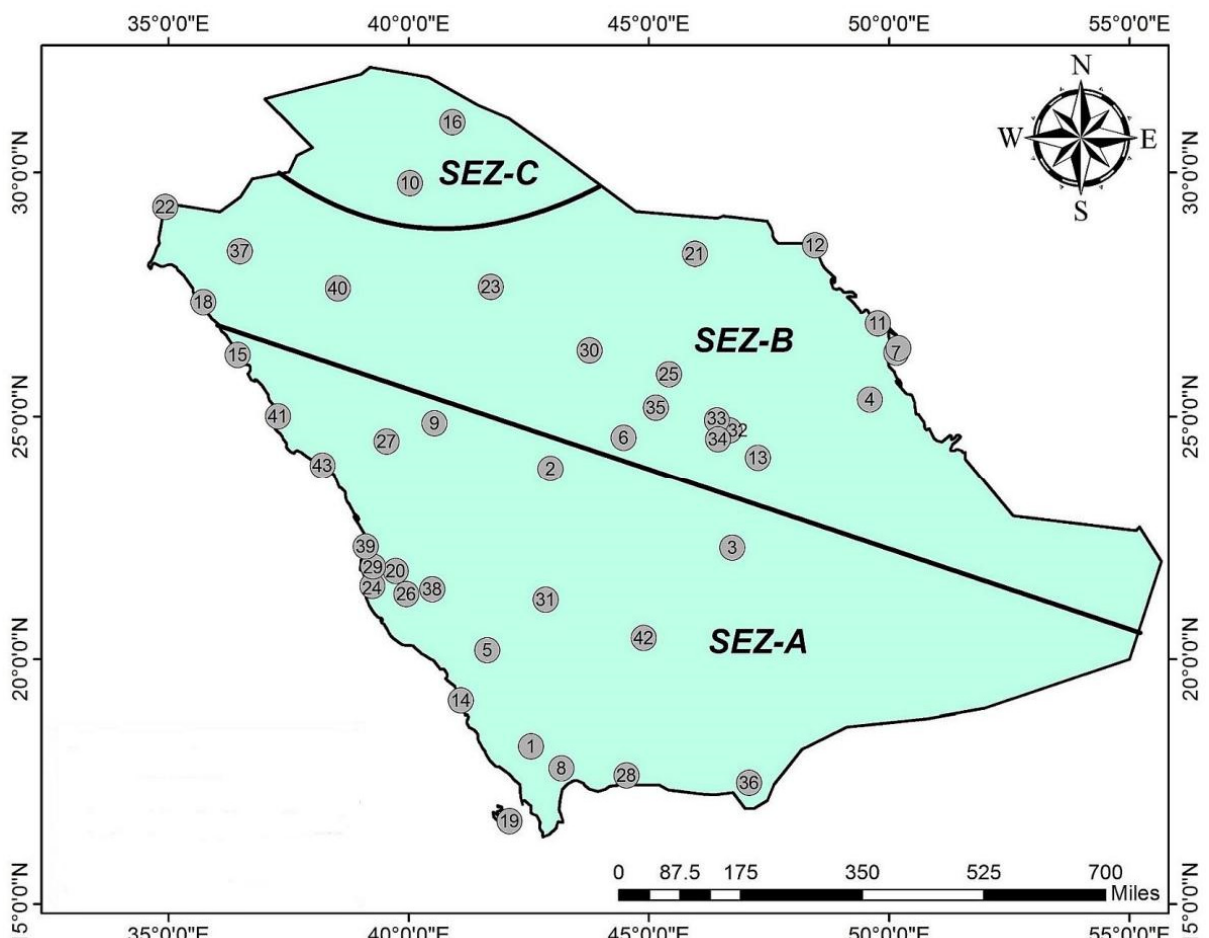
Figure 1. Distribution of the 43 sites across Saudi Arabia. The numbers refer to those in column 1, Table 1. The country was divided into 3 solar energy zones (SEZ): SEZ-A, SEZ-B, and SEZ-C, according to their solar potential estimated in a study by Farahat et al.